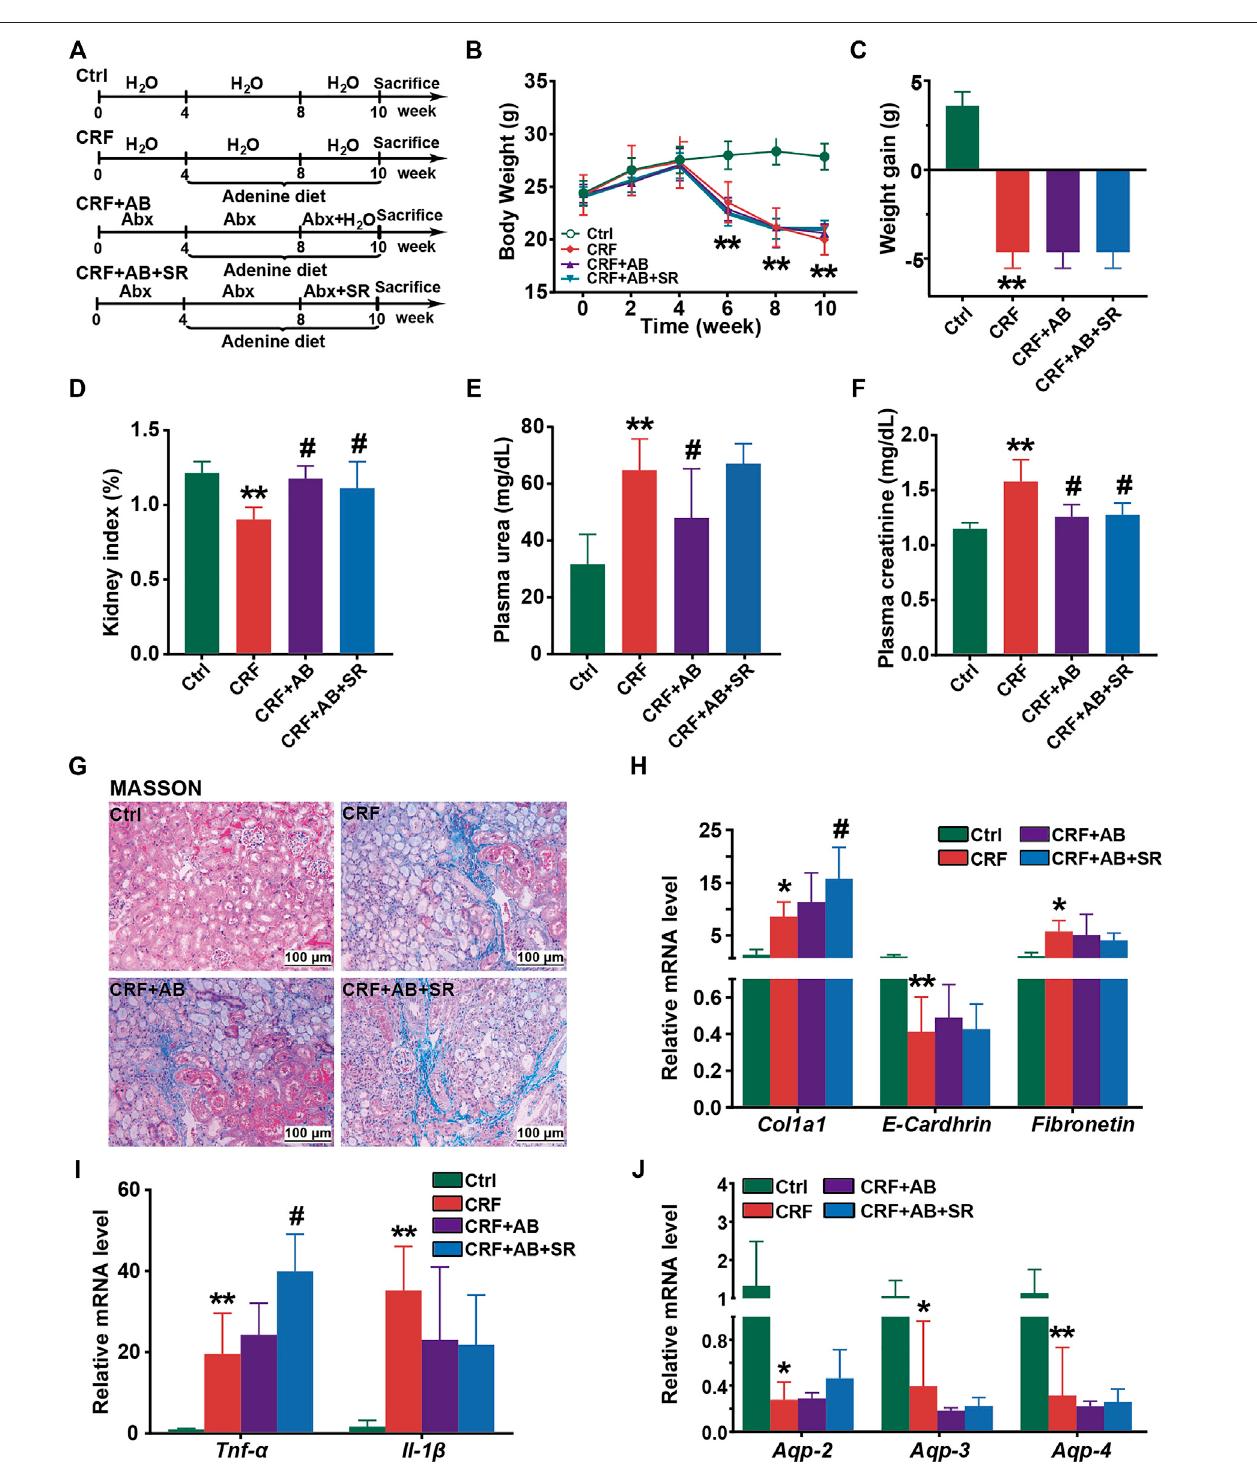
FIGURE8| EffectofSRdecoctiononCRFinmicewithgutmicrobiotadepletion. (A) Experimentalschematicdiagram. (B) Growthcurve. (C) Bodyweightgain. (D) Kidneyindex. (E) Levelofplasmaurea. (F) Levelofplasmacreatinine. (G) MASSONstainingofkidneytissues(200×). (H) Expressionofrenal fi brosisbiomarkersinkidney tissuesatmRNAlevels,including E-Cadherin , Col1a1 ,and Fibronectin . (I) Expressionofproin fl ammatorycytokinesinkidneytissuesatmRNAlevels,including Tnf- α and Il-1 β . (J) Expressionofaquaporinsinkidneytissues,including Aqp-2 , Aqp-3 ,and Aqp-4. Datawererepresentedasmean±SD(n=6).* p < 0.05,** p < 0.01 vs .Ctrl group; # p < 0.05, ## p < 0.01 vs . CRF group.